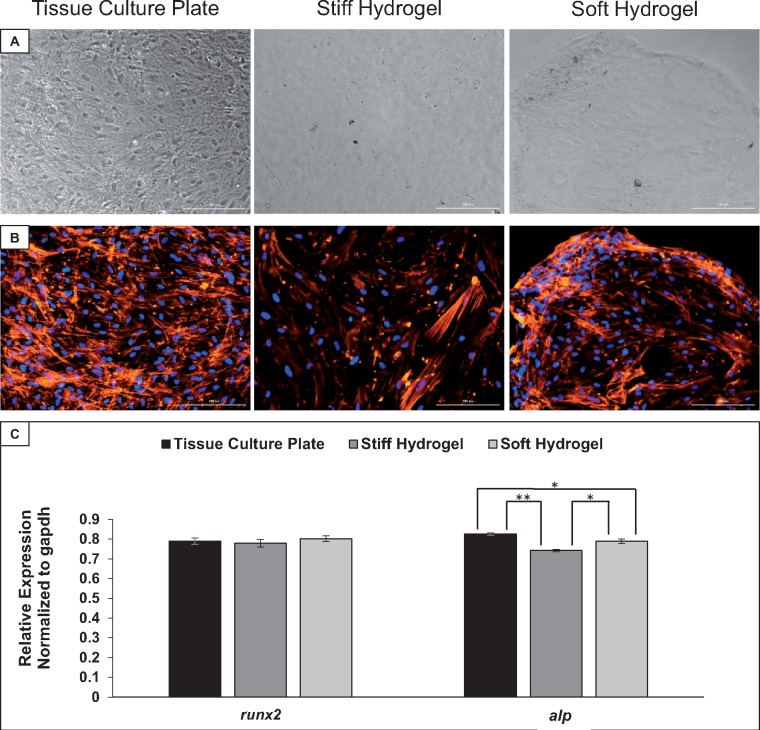
hMSCs retain the ability to differentiate toward osteogenic lineages on all three elasticity conditions. (A) Phase contrast images of hMSCs at day 7 of osteogenic differentiation. (B) Morphology of hMSCs at day 7 of osteogenic differentiation, corresponding to the phase contrast images in panel A. The cell nuclei are shown in blue, while the F-actin filaments are shown in orange. (C) Quantitative reverse-transcriptase PCR analysis of the osteogenic differentiation markers runx2 and alp in hMSCs at day 7 of osteogenic differentiation. *Tukey HSD resulting P < 0.05. **Tukey HSD resulting P < 0.01. n = 3. Scale bars: 200 µm